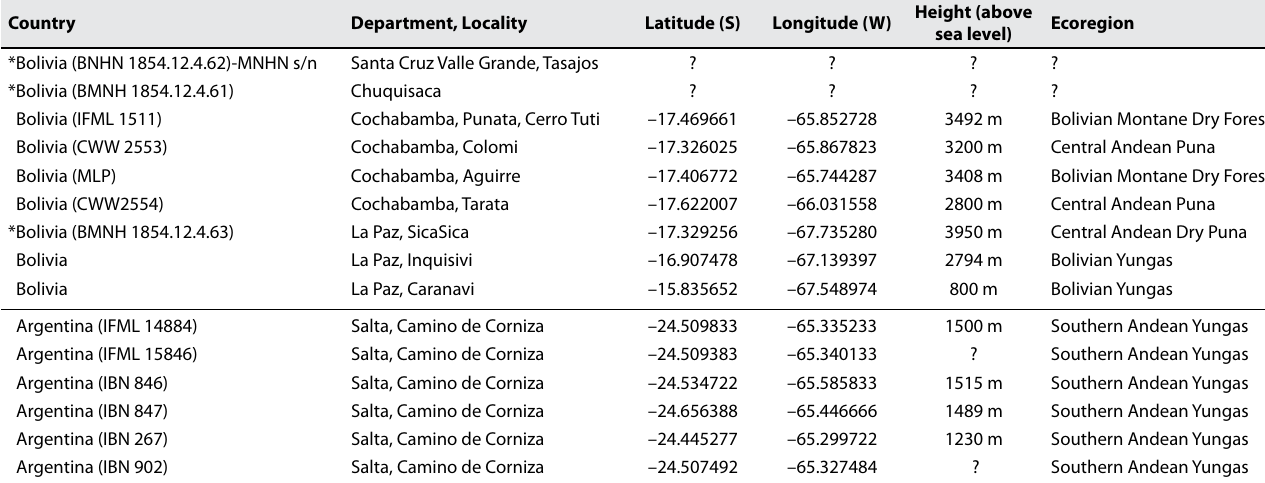
Table 1. Known record of occurrence of Epiphragmophora estella in Bolivia together with new records in Argentina. Ecoregions are according to Olson et al. (2001). Lots with an asterisk (*) are